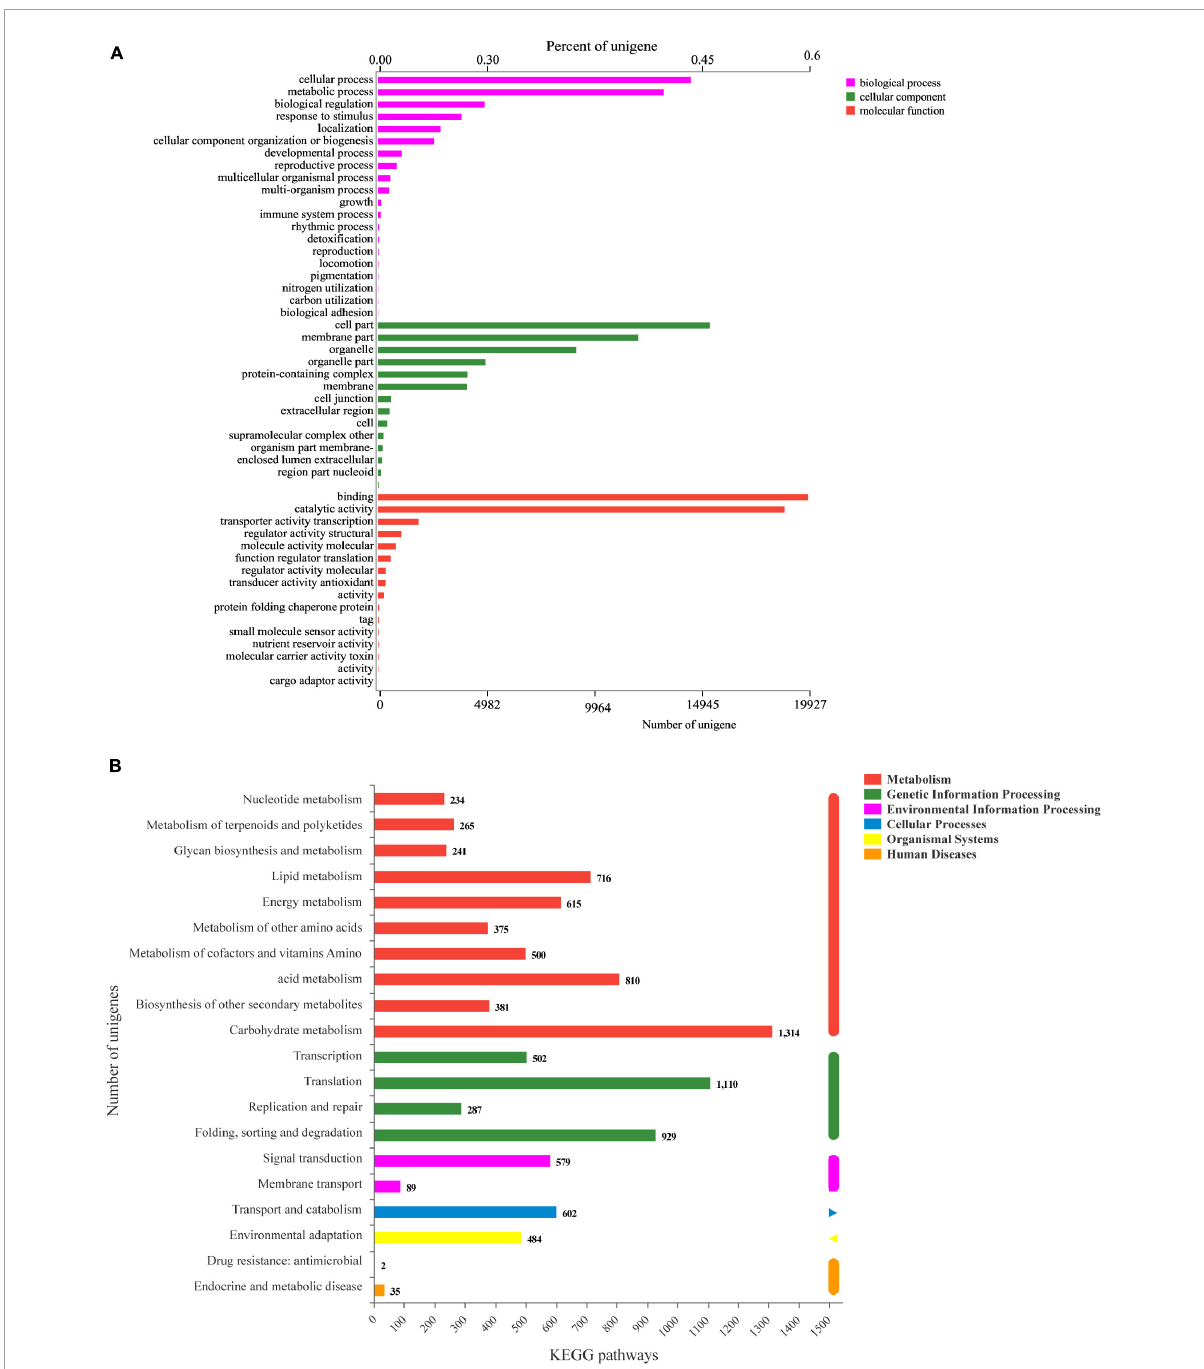
FIGURE4 Functional annotations of the unigenes of P. ternata bulbil transcriptome. (A) , GO function annotation. (B) , KEGG function annotation.